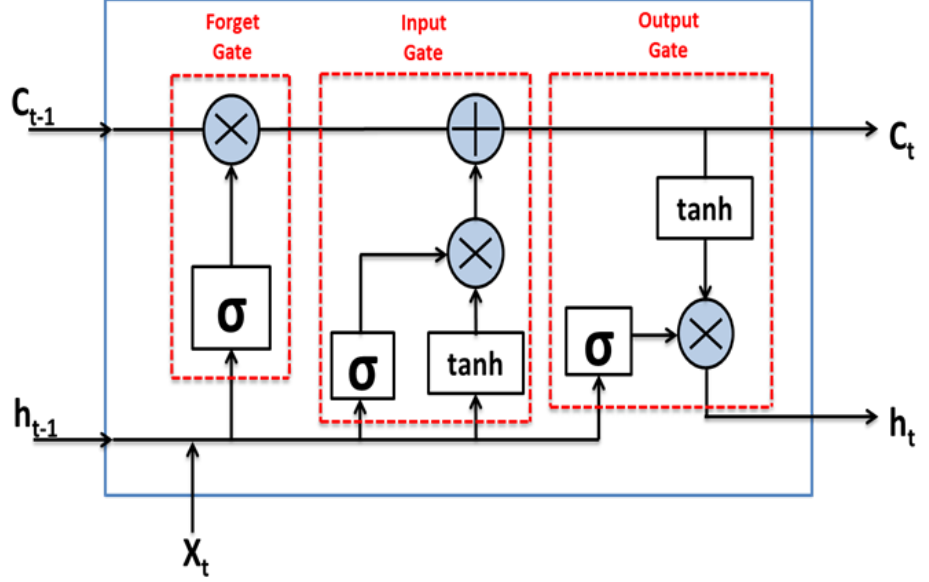
Figure 1. General architecture of the LSTM model used in this study.